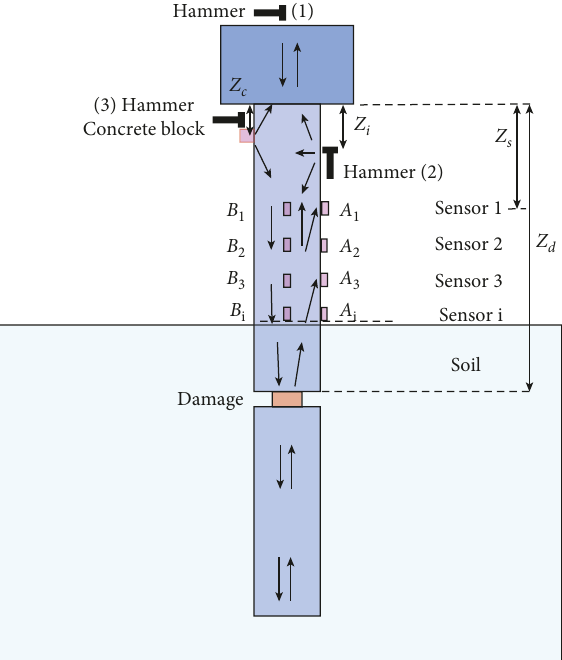
Figure 1: Sensor configuration during pile integrity